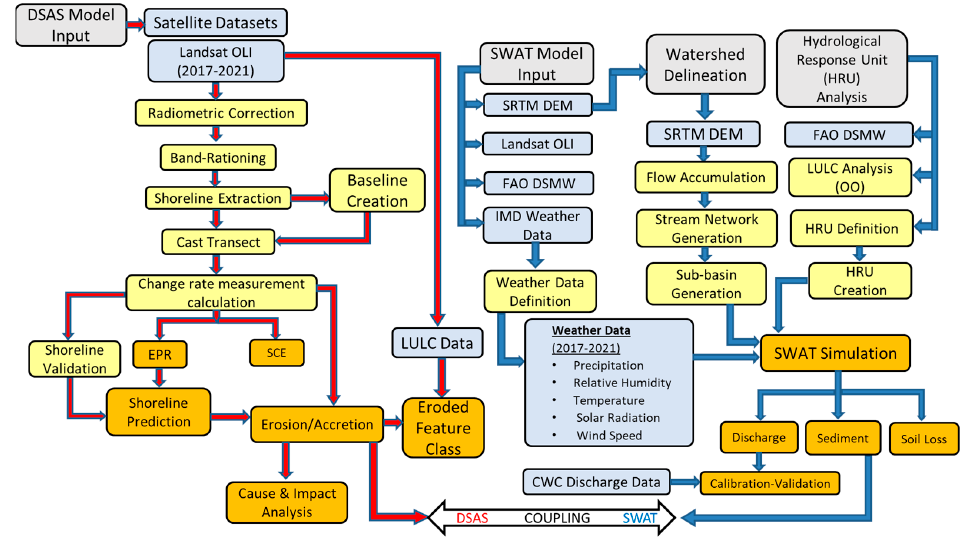
Figure 3. Flowchart illustrating the coupling SWAT and DSAS to assess the erosion-accretion scenario through the Delta sub-basins estuarine section of Subarnarekha River.